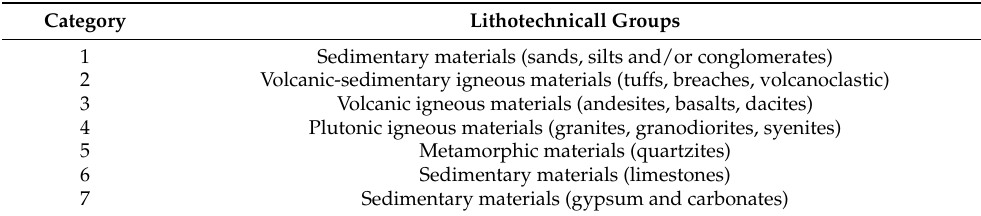
Table 3. Lithotechnical group